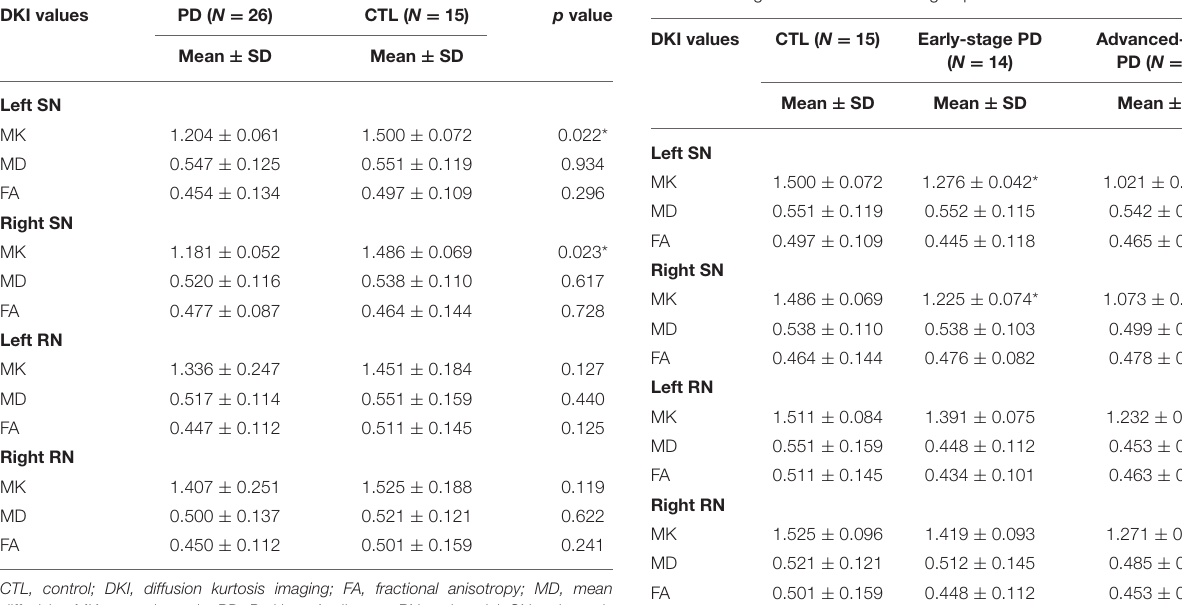
TABLE 2 | Diffusion kurtosis imaging values in the bilateral red nucleus and substantia nigra in the control, early-stage Parkinson’s disease, and advanced-stage Parkinson’s disease groups.